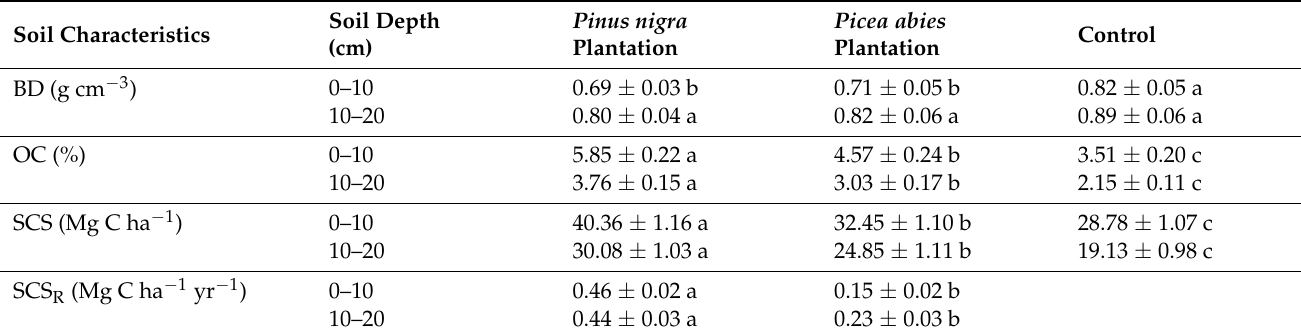
Table 9. Soil C storage (SCS) and soil carbon sequestration rate (SCS R ) (mean ± SD) in different soil depth classes at the study sites. BD, soil bulk density; OC, soil organic C.